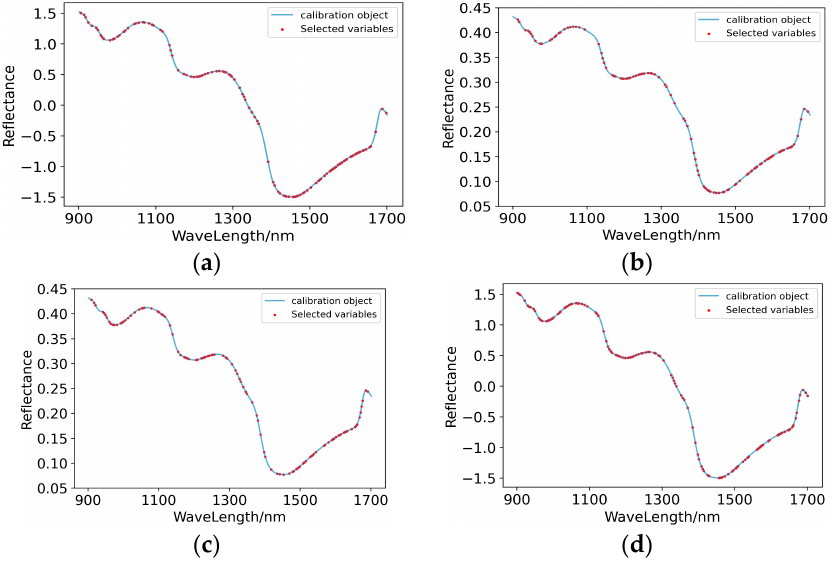
Figure 14. Characteristic wavelengths’ distribution of prediction models for the content of boron in pear peel. ( a ) SNV-GA-PLSR; ( b ) MSC-GA-PLSR; ( c ) SG+MSC-GA-PLSR; ( d ) SG+SNV-GA-PLSR.